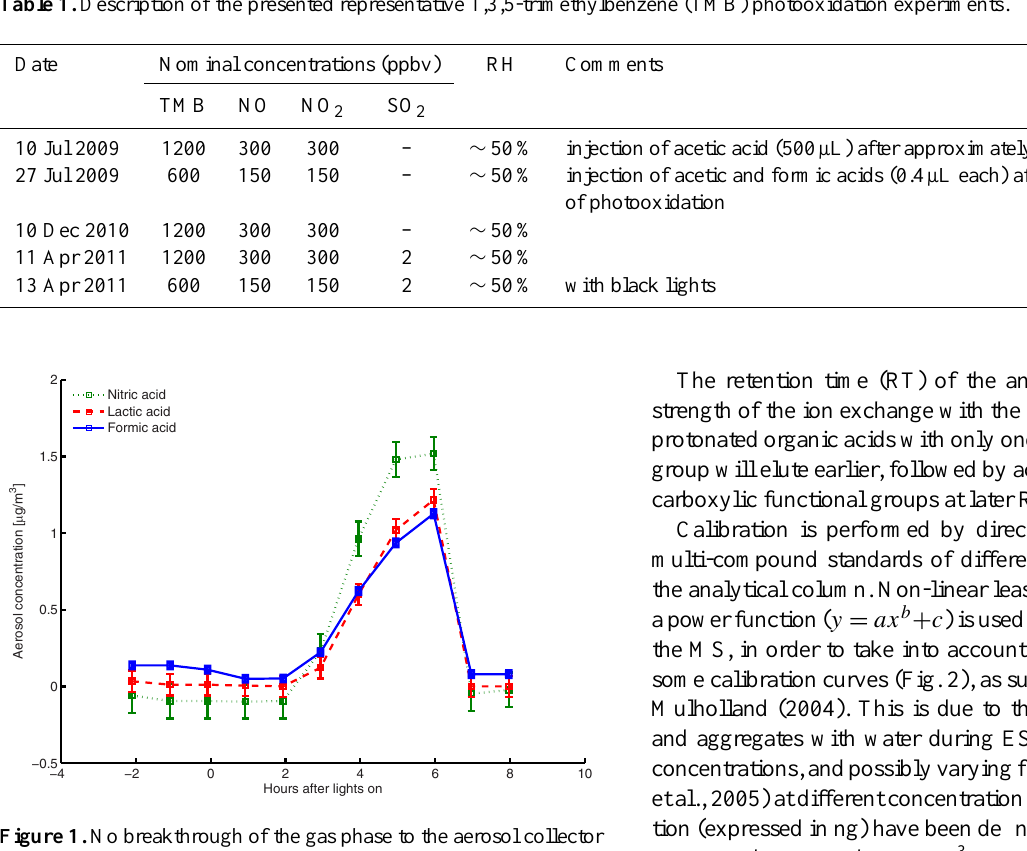
Table 1. Description of the presented representative 1,3,5-trimethylbenzene (TMB) photooxidation experiments.